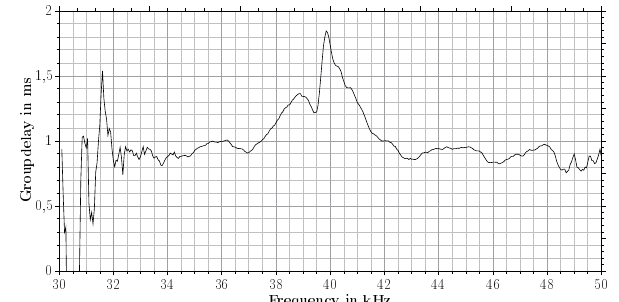
Figure 9. Measured group delay from the senders to the matched piezoelectric device. The delay is the same at the frequencies f 0 = 38 . 8kHz and f 1 = 40 . 8kHz at 1.36ms.